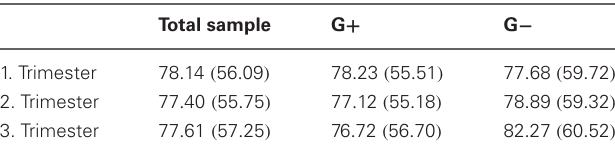
Table 5 | Conditional indirect effects of rs41423247 (G ± ) through left hippocampus volume on neuroticism.